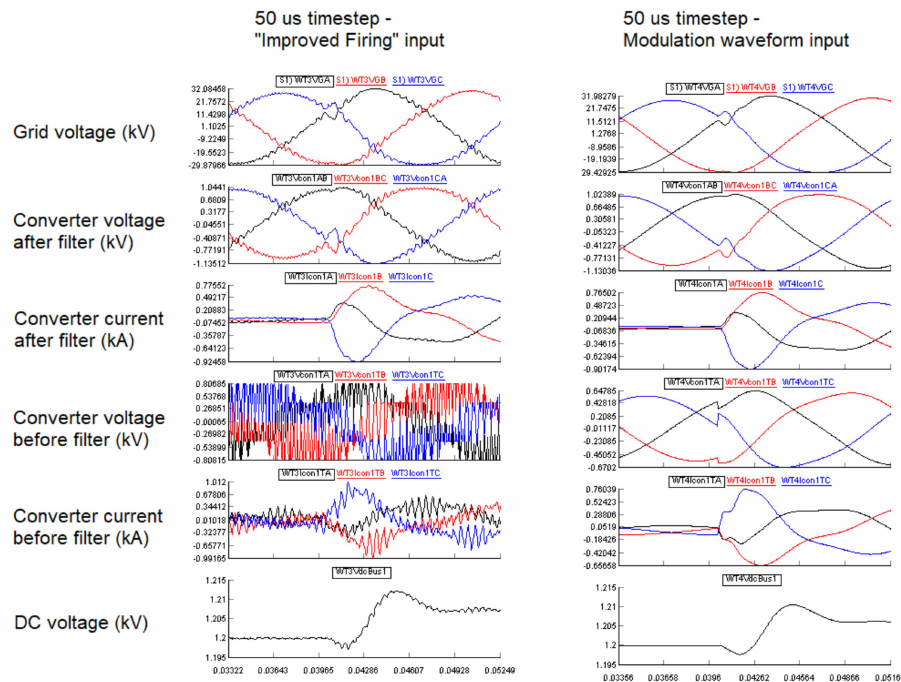
Figure 2. Simulation results for two different input modes of the universal converter model (“Im- proved Firing”, left; modulation waveform, right), running at 50 microseconds in a two-level STAT- COM application. Event shown is an AC reference voltage change from 1.0 to 1.1